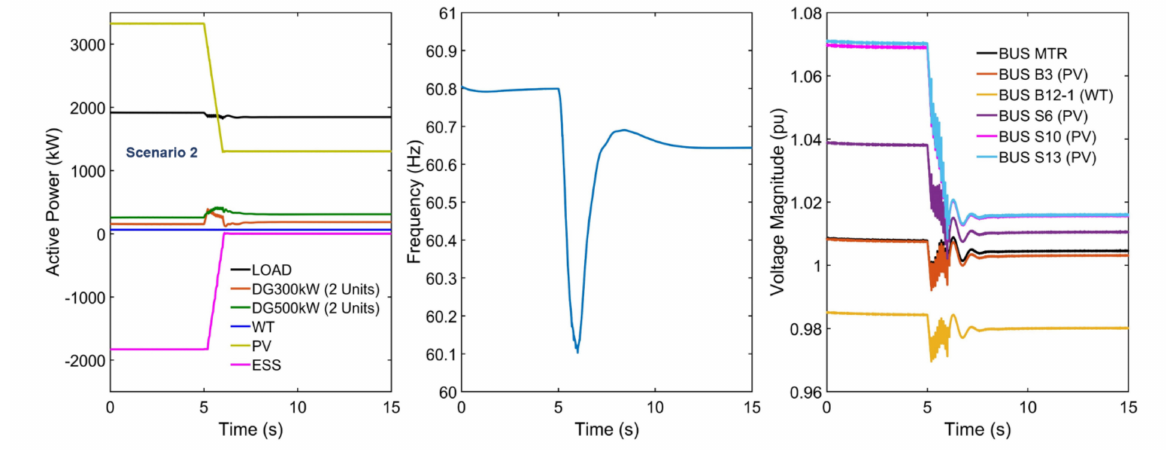
Figure 12. Active power, frequency, and voltage responses in Scenario 2.